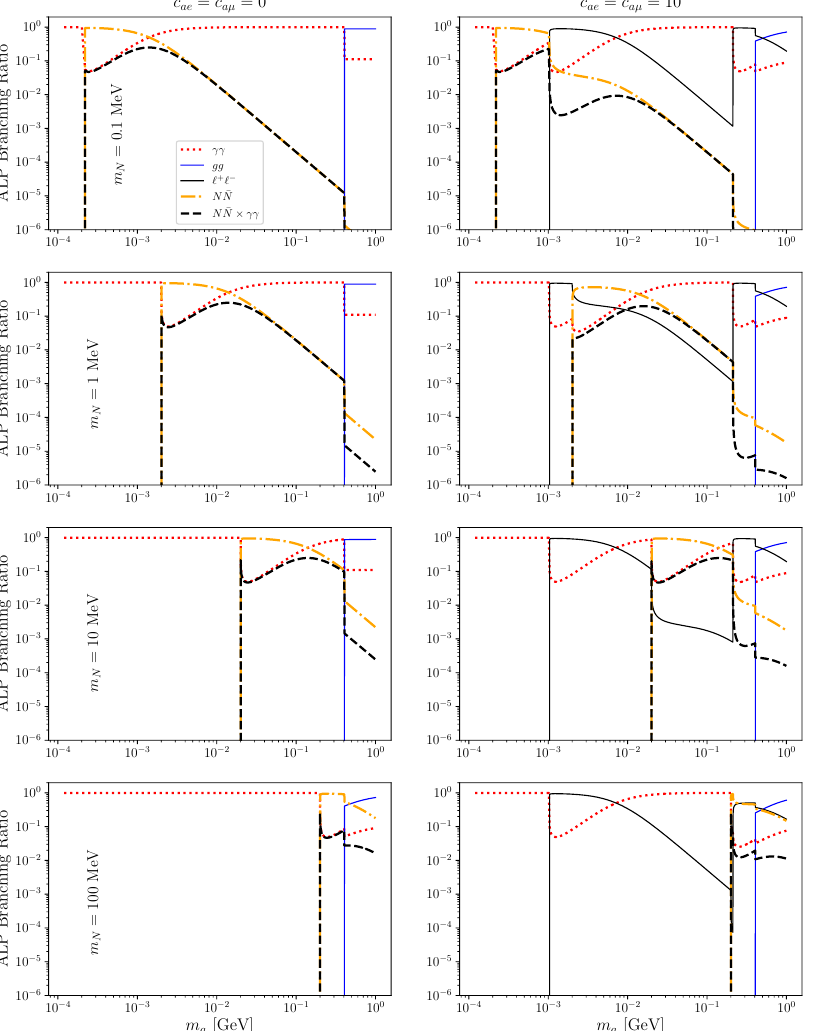
Figure 1 . The branching ratios of the ALP in the various channels allowed by the interactions of eq. (2.1) as a function of the ALP mass m a . The left(right) panels have ALP-leptons couplings set to 0(10). The sterile neutrino mass is (cid:12)xed in 0.1, 1, 10 and 100 MeV from (cid:12)rst to the last row. The dashed black lines denoted by N (cid:22) N (cid:2) (cid:13)(cid:13) represent the product BR ( a ! (cid:13)(cid:13) ) (cid:2) BR ( a ! NN